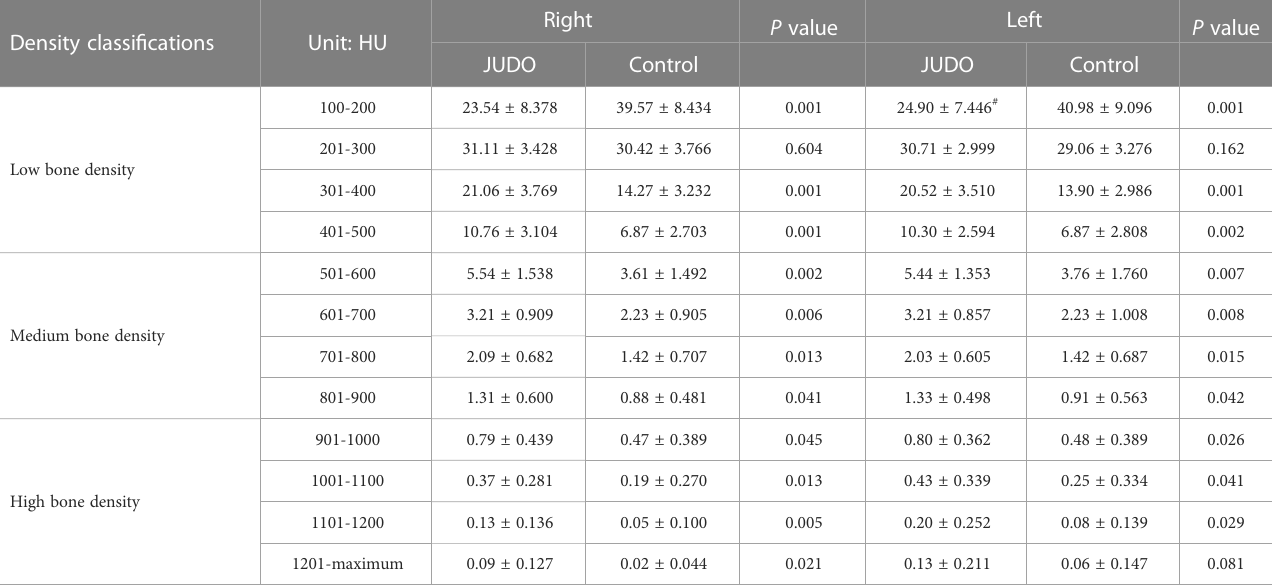
TABLE 5 Comparison of the bone tissue volume in the tibia plateau subchondral bone between the groups